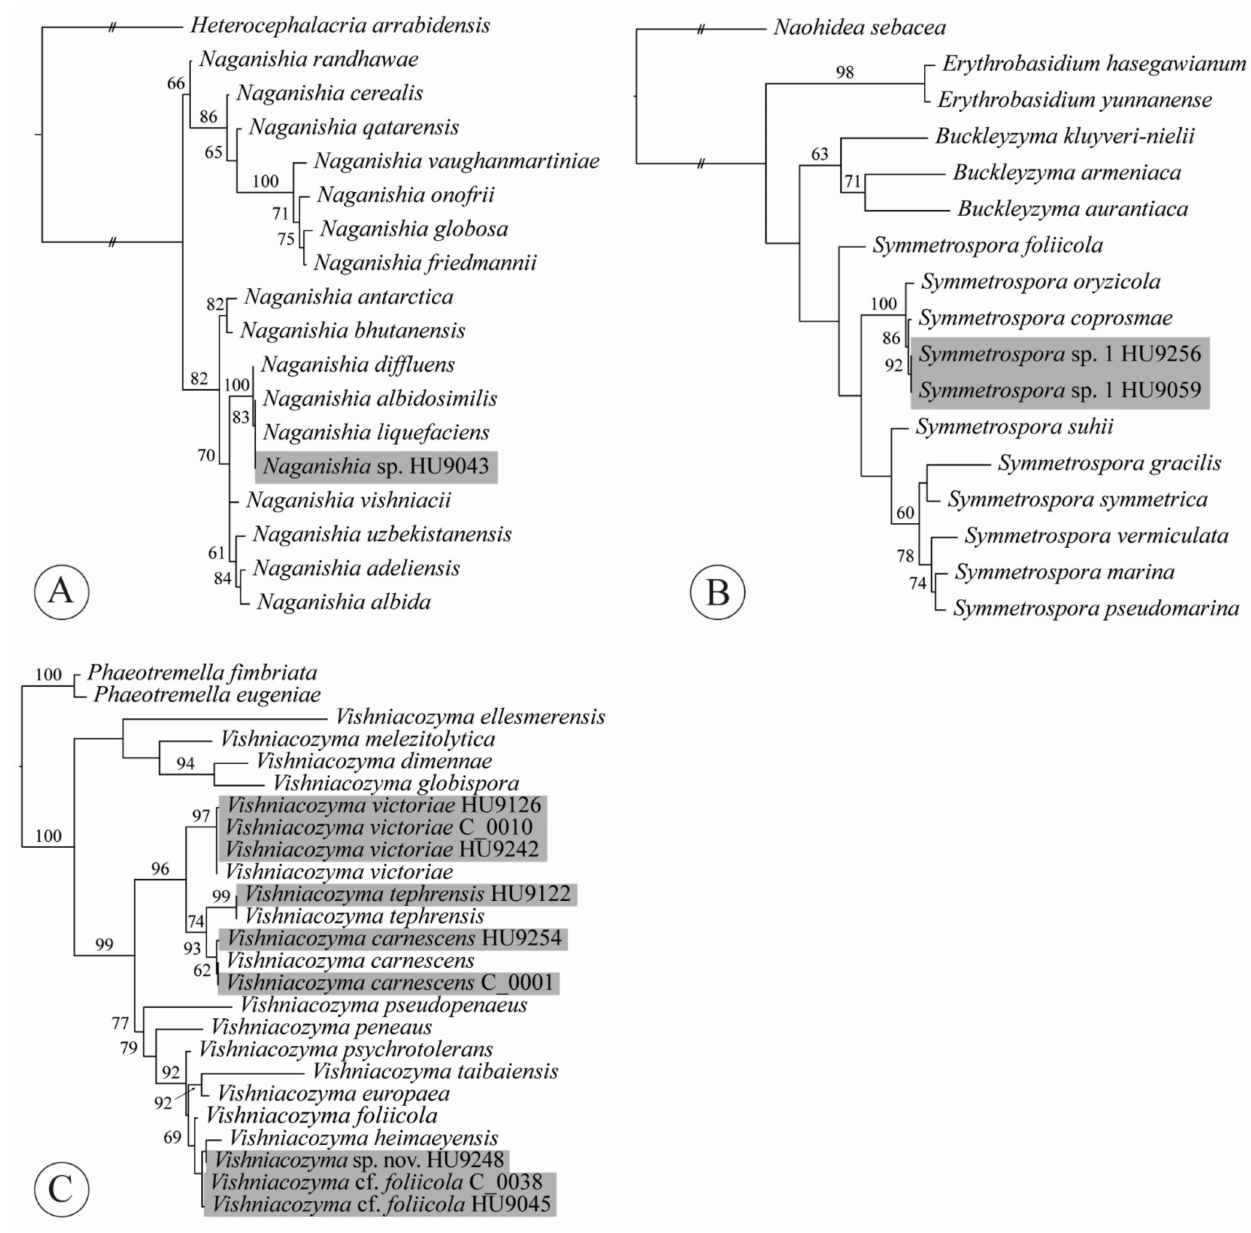
Figure 5. Phylogenetic reconstructions based on ITS sequences for the following genera: ( A ), Naganishia ; ( B ), Symmetrospora ; and ( C ), Vishniacozyma . Topologies are the result of ML inference performed with IQ-TREE. For each node, the ML bootstrap (if ≥ 60) is presented above/below the branch leading to that node. Gray shading added for strains obtained from romaine lettuce samples during this